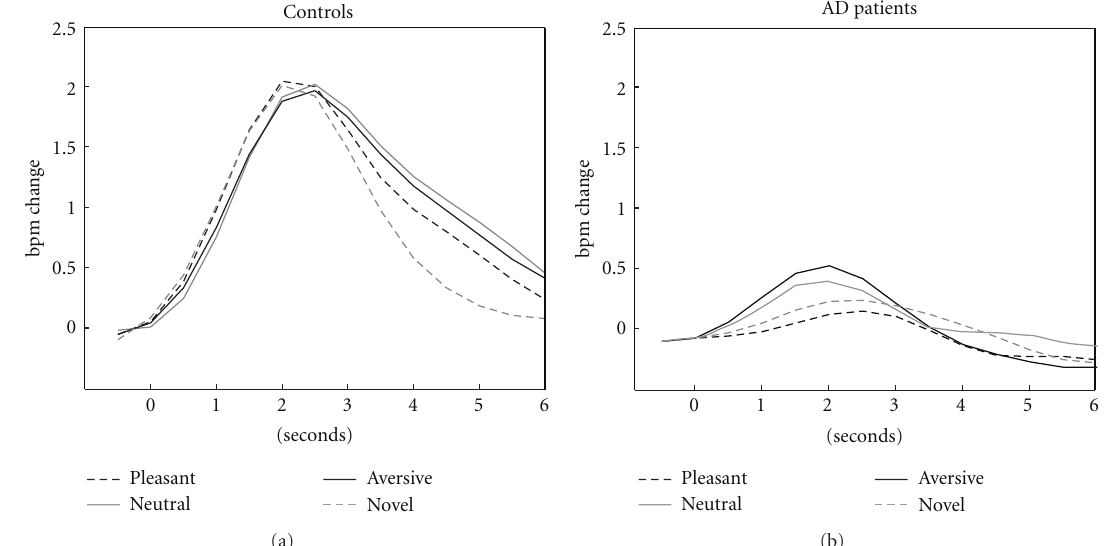
Figure 1: Mean heart rate response of patients and controls for pictures associated with pleasant, neutral, and aversive content and a novel stimulus.